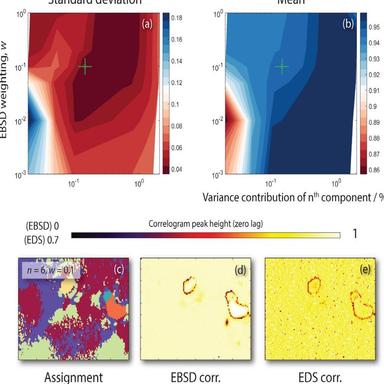
Standard deviation (a) and mean (b) of combined EBSD and EDS RCC/measurement cross-correlation peak heights, χcomb, defined in. The 'best' assignment map is presented (c), along with correlation peak height maps for EBSD, χEBSD (d) and EDS, χEDS (e). 36 data points are included in the t / w parameter space maps.